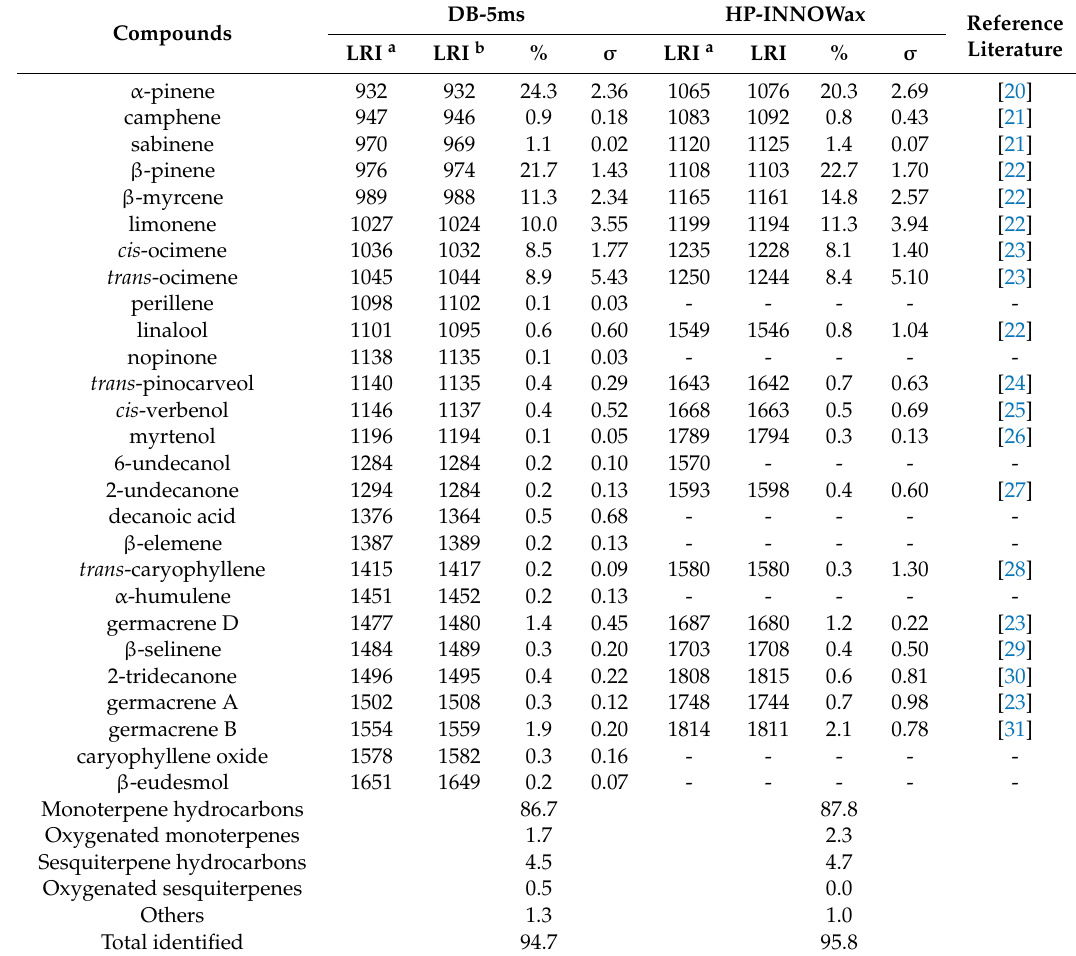
Table 1. Chemical composition of the essential oil distilled from Siparuna echinata .